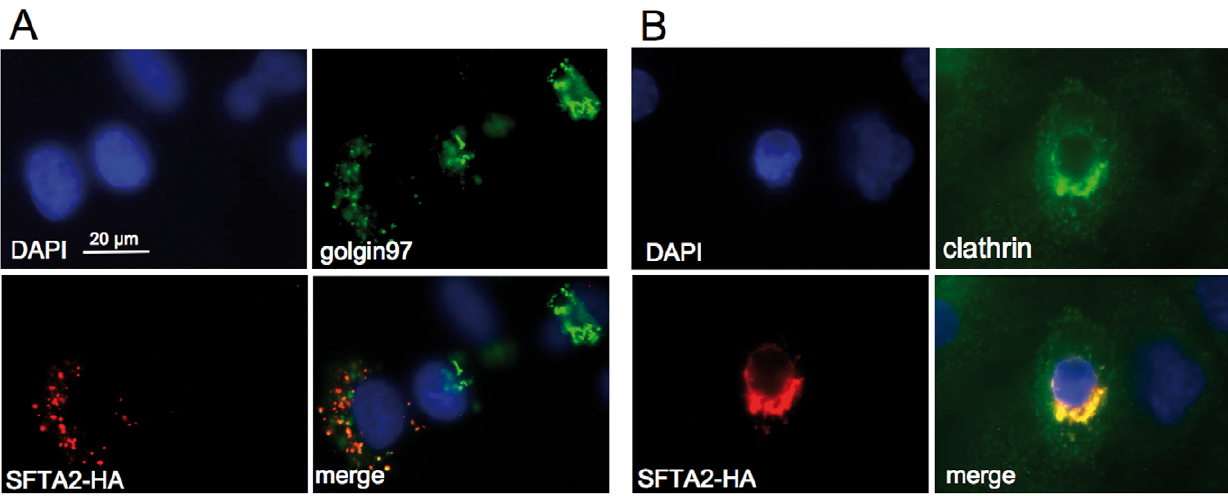
Figure 3. Immunofluorescence microscopic analysis of A549 cells transfected with an HA epitope-tagged SFTA2 expression plasmid. A. Partial colocalization with golgin97 indicates passage of SFTA2 through the Golgi apparatus. B. Partial colocalization with clathrin indicates presence of SFTA2 in secretory vesicles consistent with the classical pathway of secretion.